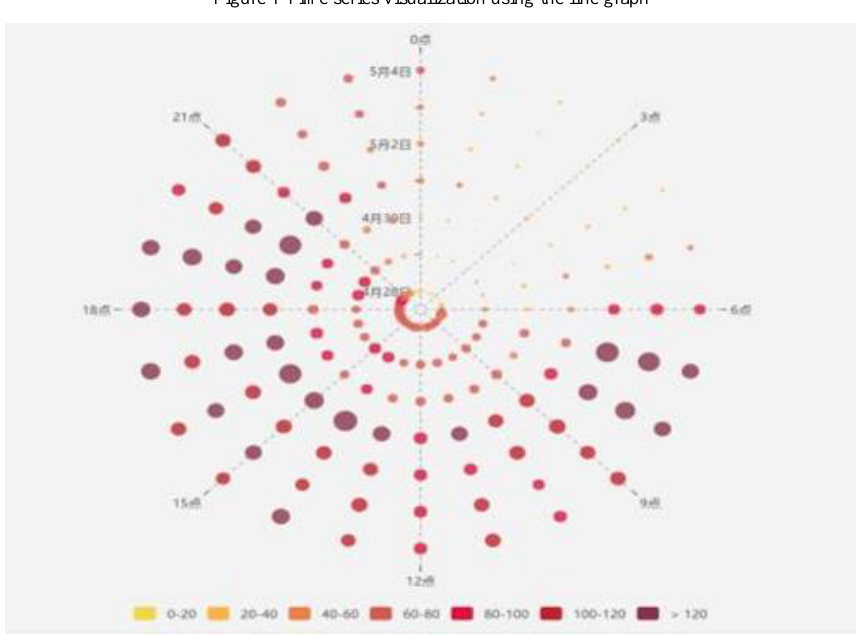
Figure 1 Time series visualization using the line graph